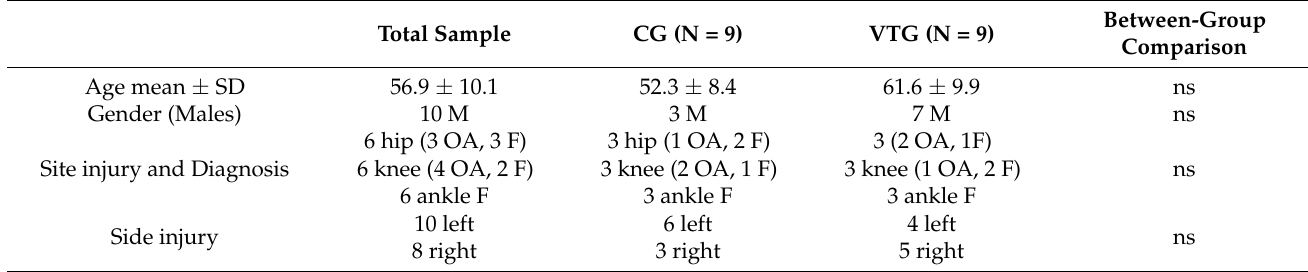
Table 1. Demographic and clinical profile of the two groups at baseline.